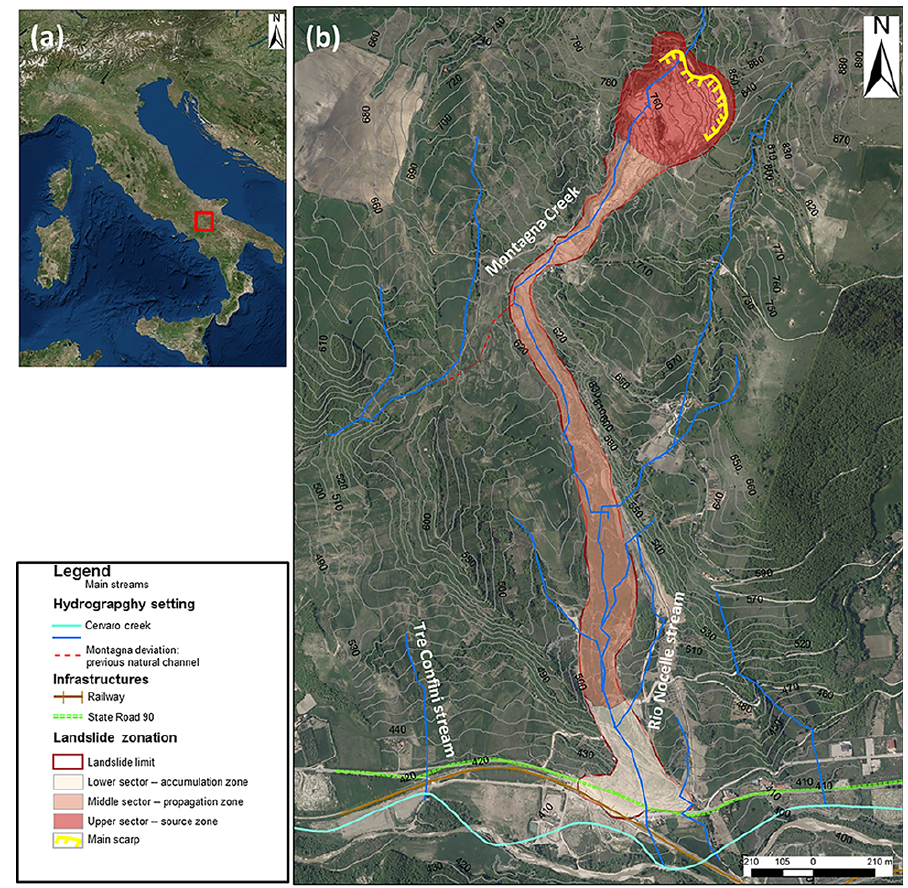
Figure 1. (a) Location map. (b) Map of the Montaguto area shown with the main landslide features, including the element at risk (infrastruc-